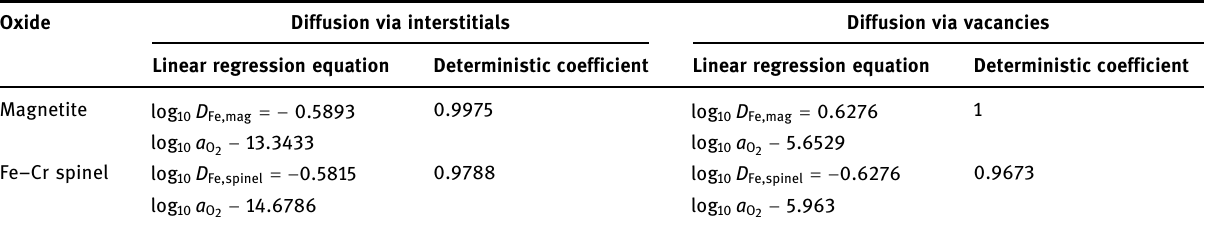
Table 3: One - dimensional linear regression equation over logarithm values of iron diffusion coefficients and logarithm values of oxygen activities at 1,200°C, and deterministic coefficient Oxide Diffusion via interstitials Diffusion via vacancies Linear regression equation